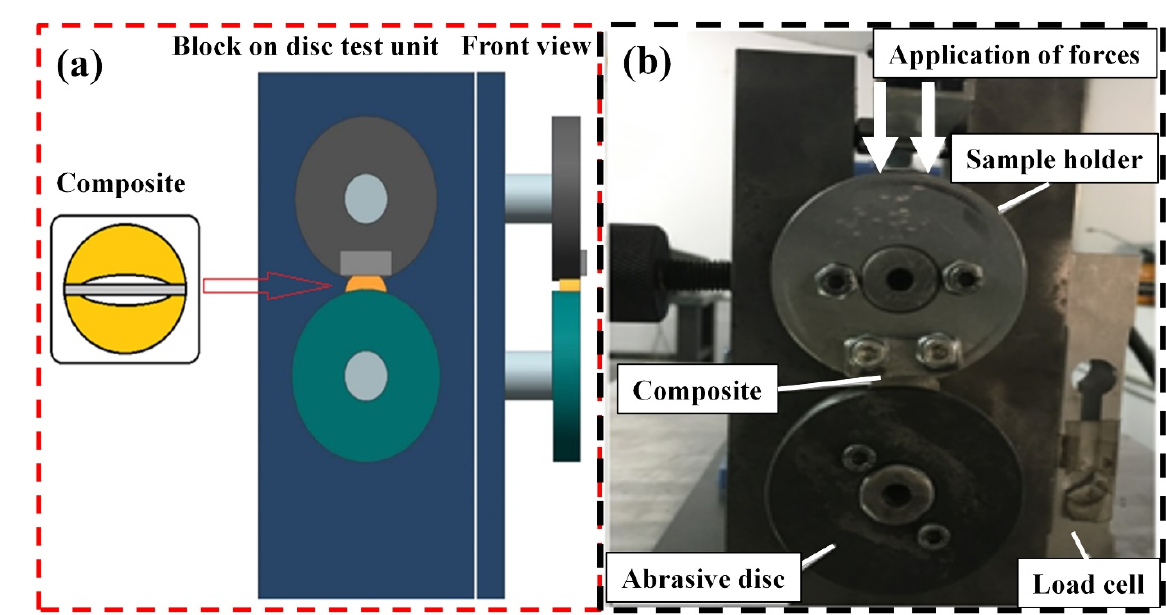
Figure 2. ( a ) Schematic view of the wear test setup, and ( b ) wear test machine [28].